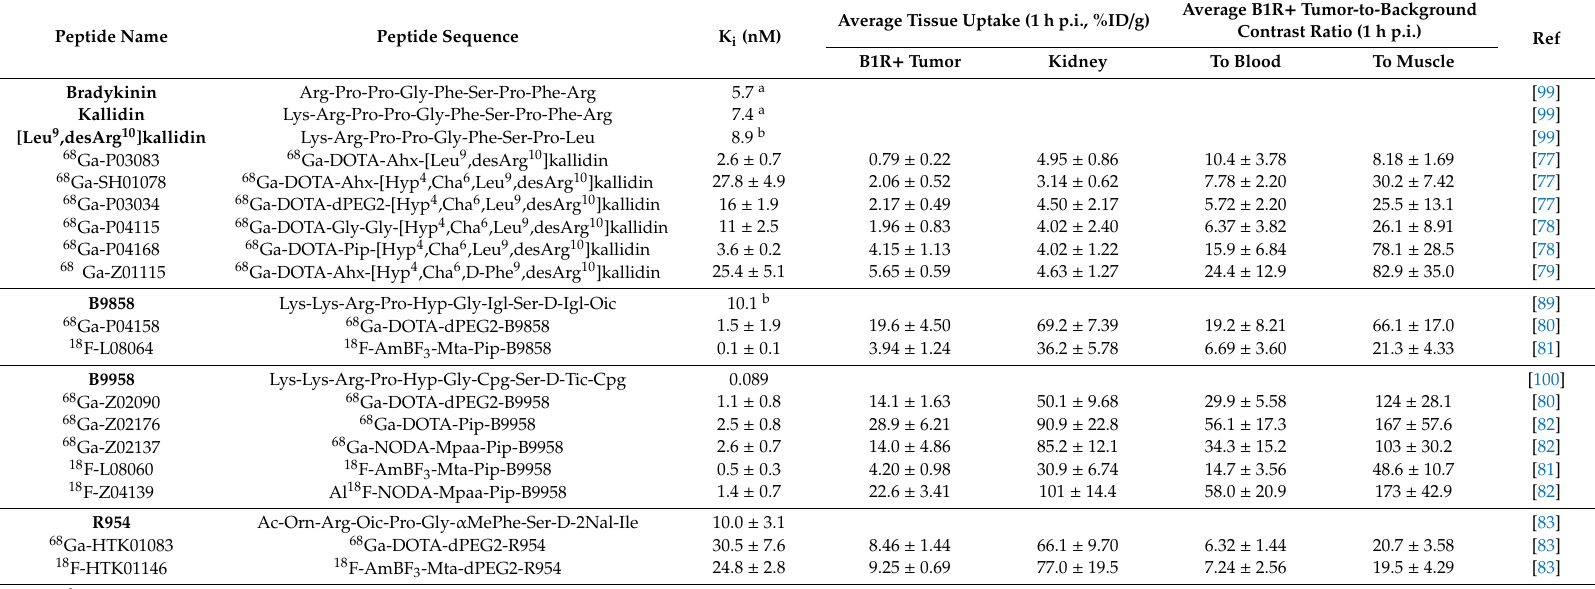
Table 2. Comparison of binding a ffi nity, hydrophilicity, tracer uptake, and uptake ratios of selected B1R-targeting peptides. Adapted from